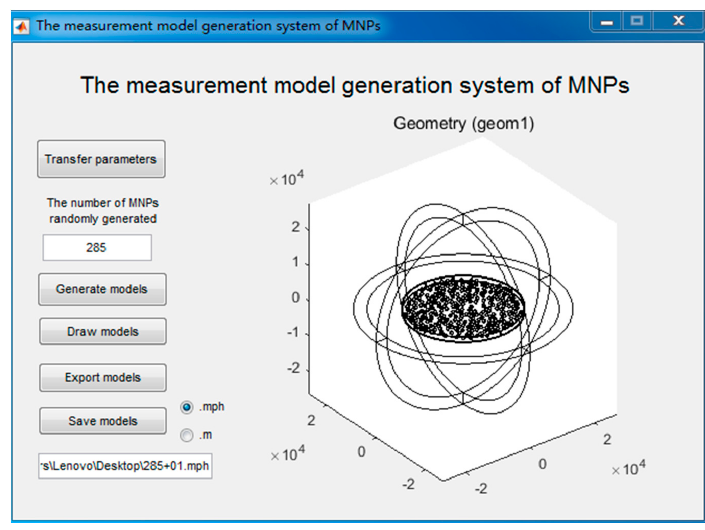
Figure 6. The measurement model generation system of MNPs based on MATLAB GUI.